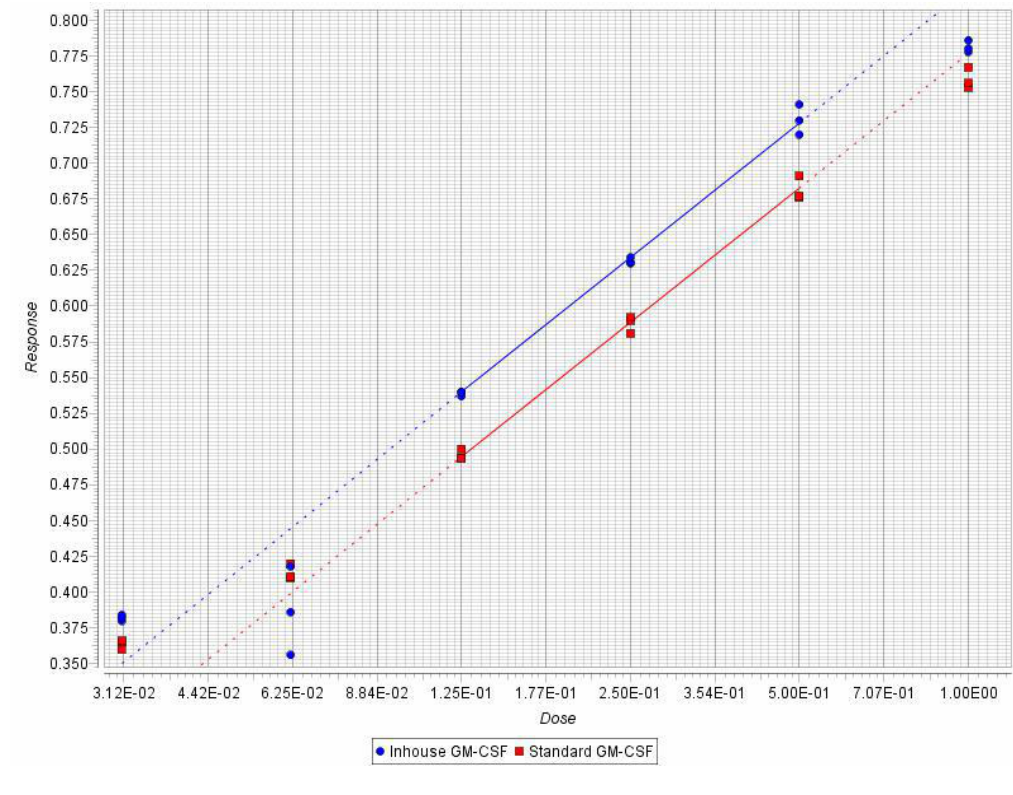
Figure 6. The biological activity of in-house hGMCSF was assessed using TF-1 cell proliferation assay. The activity data was analyzed statistically using Parallel Line Assay software (PLA 2.0). The doses are indicated on the horizontal axis, whereas the corresponding responses are represented on the vertical axis. The individual responses for each treatment are symbolized by the red squares for the standard preparation and by the blue circles for the sample